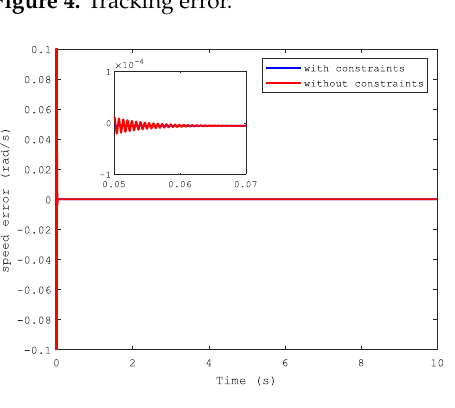
Figure 5. Speed error.